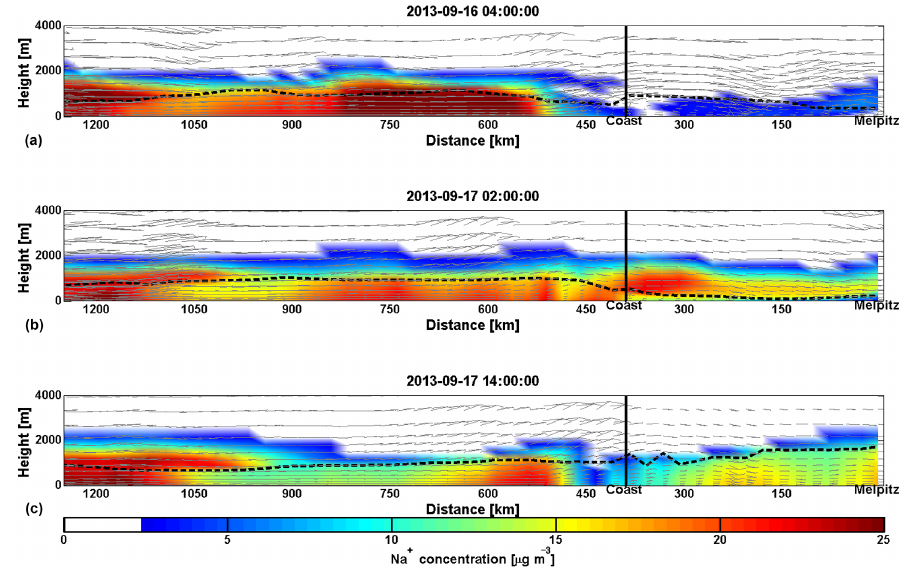
Figure 8. WRF-Chem result of the sea salt (Na + ) concentration on the vertical cross section, which is shown by the black dash line in Fig. 2. The locations of Melpitz and coast (black line) are marked. The grey arrows indicate the wind field, and the black dash line indicates the planetary boundary layer (PBL) height. (a) 16 September 2013, 04:00LT; (b) 17 September 2013, 02:00LT; (c) 17 September 2013,